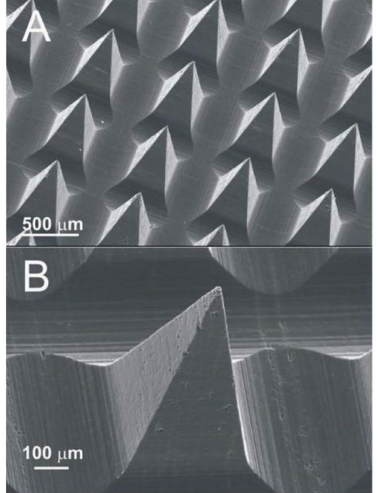
Figure 2. ( A ) Electron micrograph of a 10 × 10 MN array formed from the solution casting of polystyrene. ( B ) Individual morphology of a 400 × 400 × 800 micron polystyrene